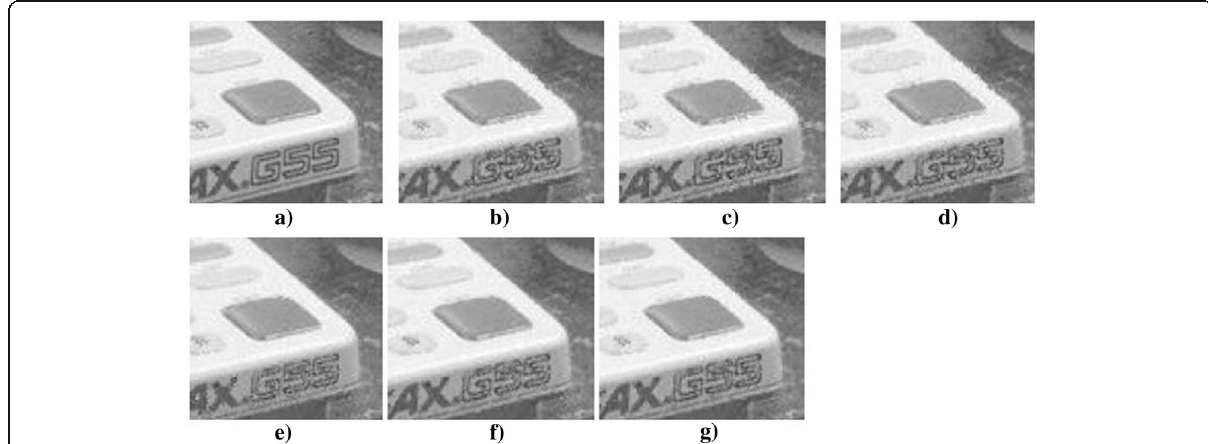
Fig. 7 Zoomed results with 30% impulsive noise. a Original image. b AMF. c AWMF. d Bhateja [20]. e SAMF. f Bhadouria [21]. g Proposed